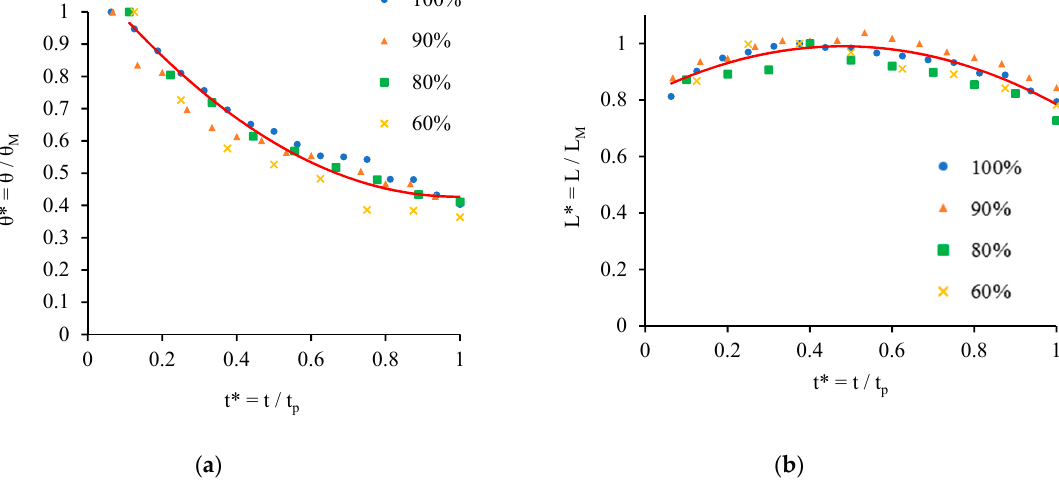
Figure 10. Contact angle ( a ) and droplet base diameter dimensionless ( b ) profiles for different percentage (%) concentrations of surfactants on dry dish sponge.